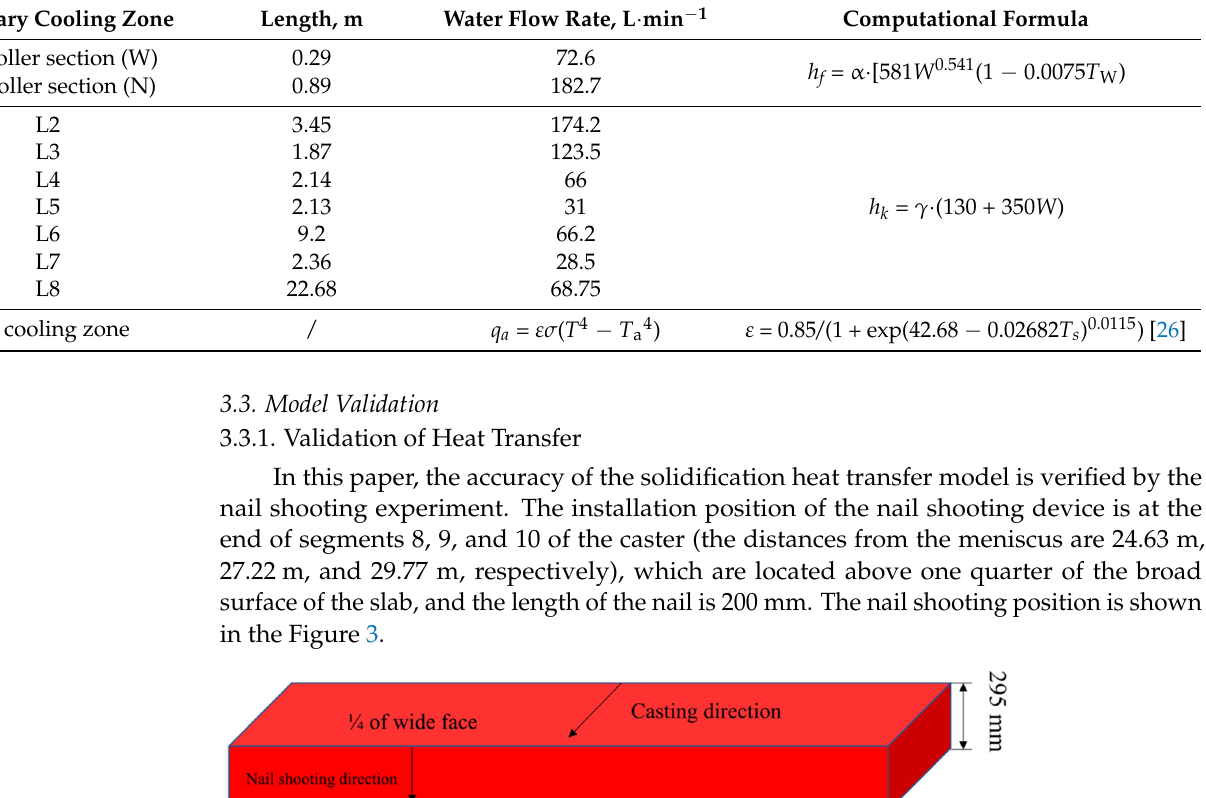
Figure 4. Photographs of sulfur printing samples for nail shooting experiments on S-4 steel: ( a ) The end of segment 8; ( b ) the end of segment 9; ( c ) the end of segment 10.